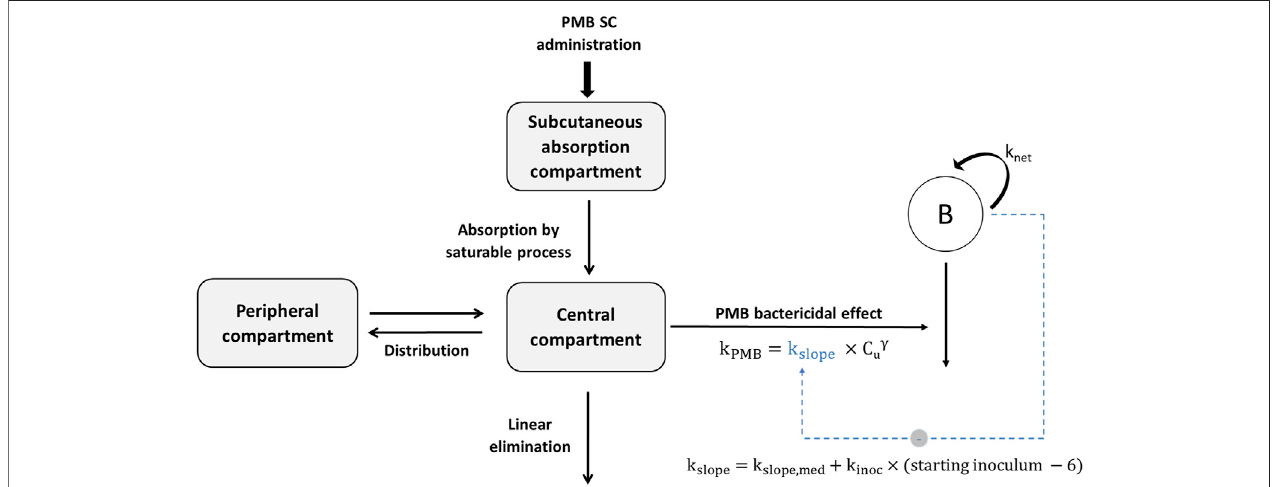
FIGURE 1 | Schematic representation of the fi nal pharmacokinetic-pharmacodynamic model characterizing the inoculum effect of A. baumannii on PMB bactericidal activity (k PMB ). SC, subcutaneous; k net , apparent growth rate constant of bacteria; k slope , kill rate constant due to PMB; k slope,med , kill rate constant for a theoreticalstartinginoculumof6log